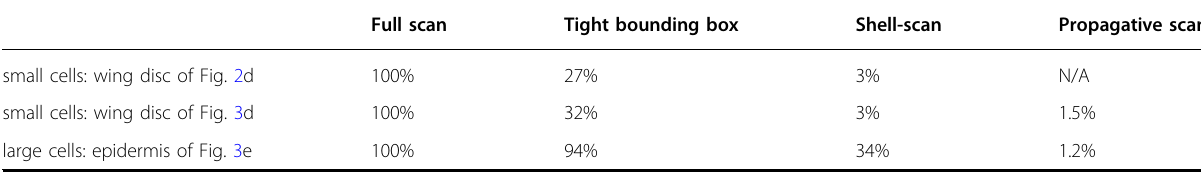
Table 1 Reduction in scanned volumes in the shell-scan and propagative scan for the tissues analyzed in Fig. 3. Full scan Tight bounding box Shell-scan Propagative scan small cells: wing disc of Fig. 2d 100% 27% 3% N/A small cells: wing disc of Fig. 3d 100% 32% 3% 1.5% large cells: epidermis of Fig. 3e 100% 94% 34% 1.2% The contribution in the reduction from scanning a tight bounding box around the tissue is also added. Other comparisons are provided in Figs. S5, S6, and S7